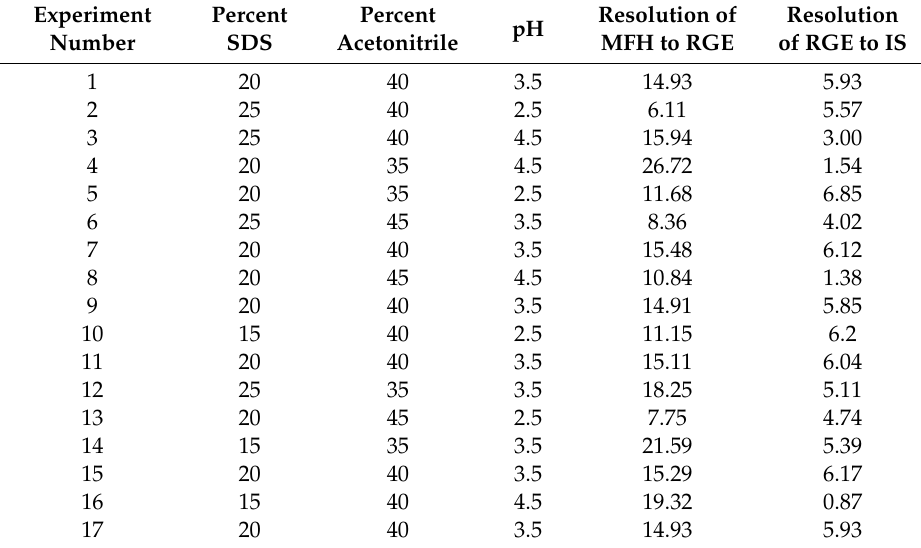
Table 1. Box–Behnken model for optimization of chromatographic